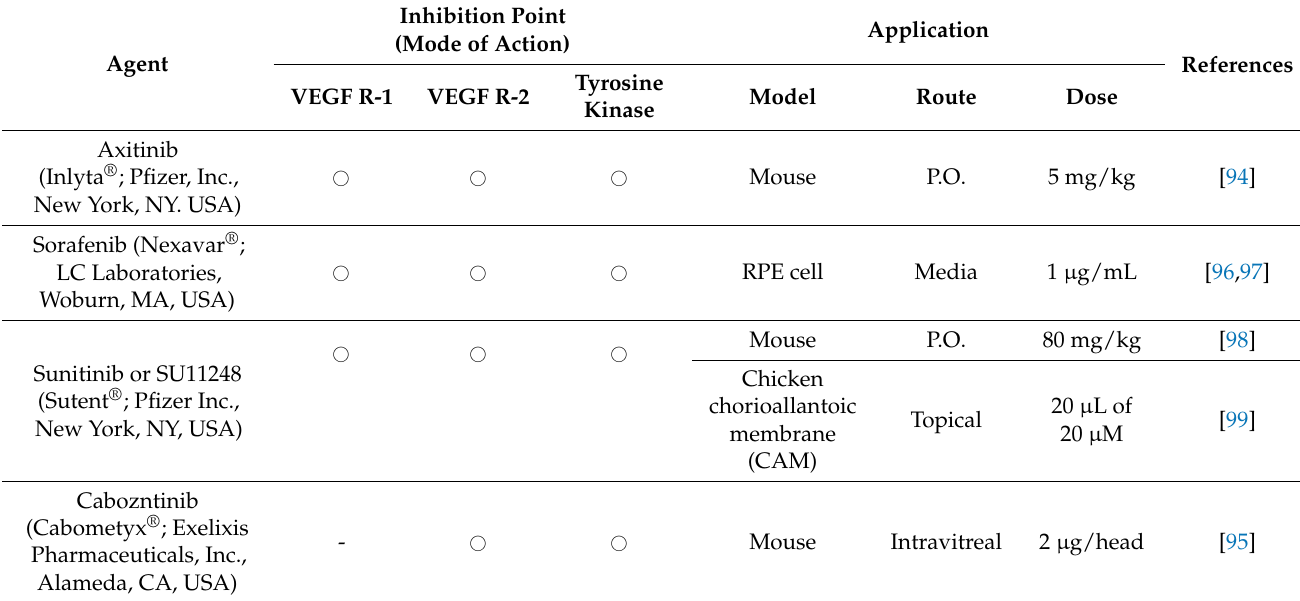
Table 6. Summary of the developed anti-vascular endothelial growth factor (anti-VEGF) drugs for AMD treatment.